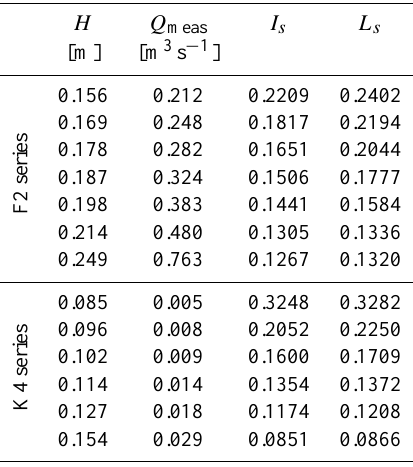
Table 2. Sensitivities I s and L s computed in the F2 and K4 series for the optimal parameter